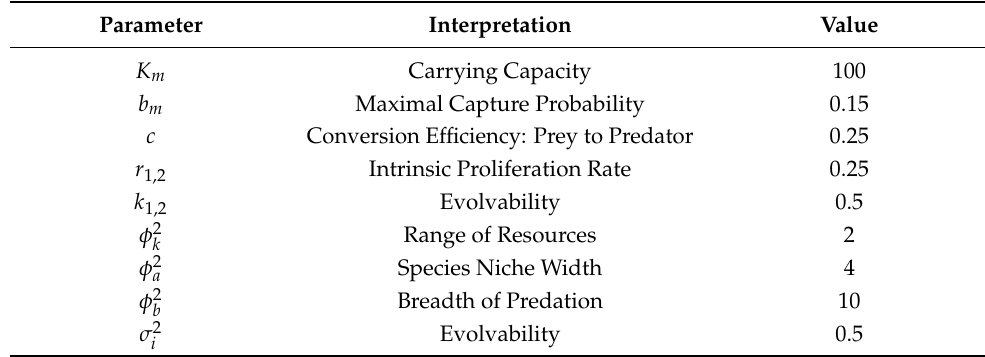
Table 2. Parameter values used in predator–prey